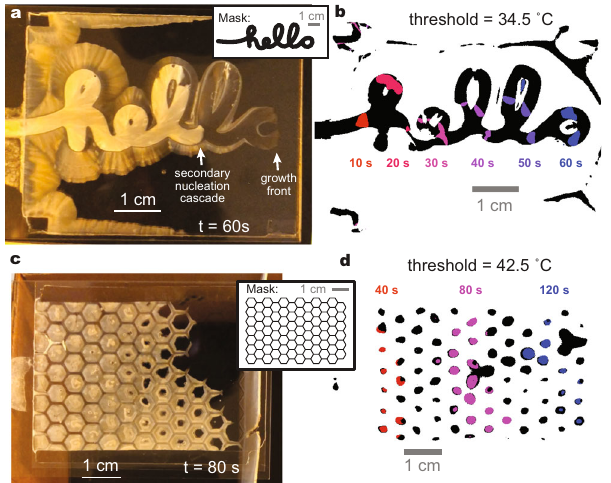
Fig. 4 Spatiotemporal evolution of thermal pro fi les from patterned sodium acetate trihydrate crystal growth. Temperature was monitored with an infrared camera. Precursor solution composition for all samples: 7.0M sodium acetate, 2.8M acrylamide, 13mM N,N ′ -methylenebisacrylamide, 2mM α -ketoglutaric acid in water; 0.5mm spacer. a Image of crystal growth in a sample that had been photopolymerized through a mask spelling out the word “ hello ” with light blocked within the letters. Sample was crystallized on a cold plate held at 18°C. Full optical and thermal video available (Supplementary Movie 4). b Sum of thresholded thermal images of the sample shown in ( a ). Regions that reached a threshold temperature of 34.5°C over the course of sample crystallization are shown in black. Regions that exceeded this threshold at 10-s interval snapshots are shown in a spectrum from red to blue. c Image of crystal growth in a sample that had been photopolymerized through a hexagonal grid mask with light blocked by the lines. Sample was crystallized in air rather than on a heat sink; as such, heat was allowed to accumulate in areas where fronts converged. Full optical and thermal video available (Supplementary Movie 5). d Sum of thresholded thermal images of the sample shown in ( c ). Regions that reached a threshold temperature of 42.5°C over the course of sample crystallization are shown in black. Regions that exceeded this threshold at 40-s interval snapshots are shown in red, magenta, and blue.